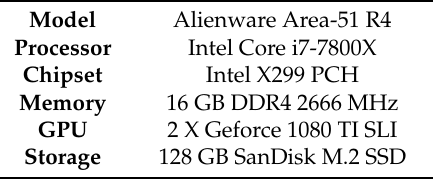
Table 4. Specifications of the PC on which the driving simulator is run.